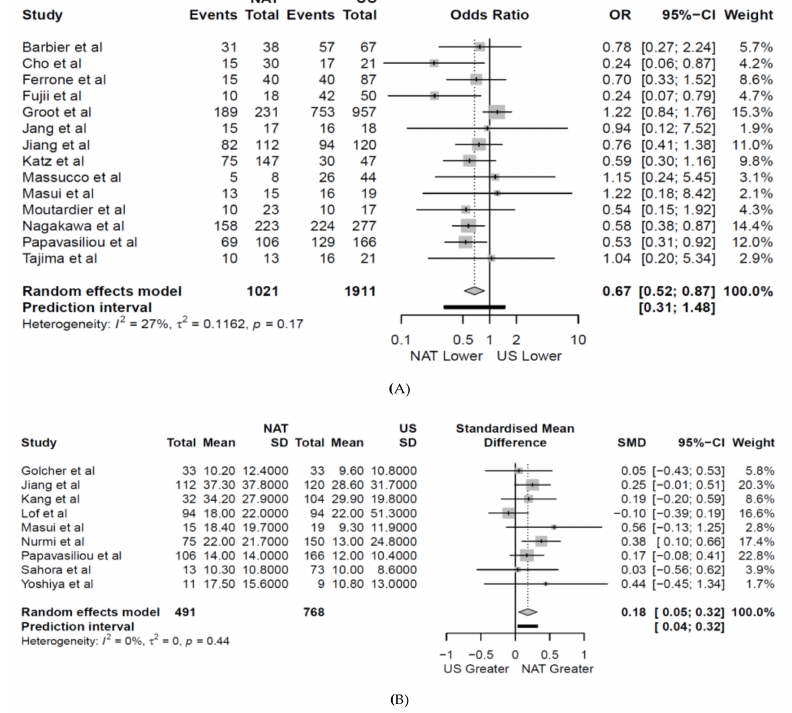
Figure 5. Forest plot showing: ( A ) overall recurrence rates ( n ) and ( B ) time to first recurrence (months) following neoadjuvant therapy (NAT) vs. up-front Surgery (US). A Manel-Haenszel